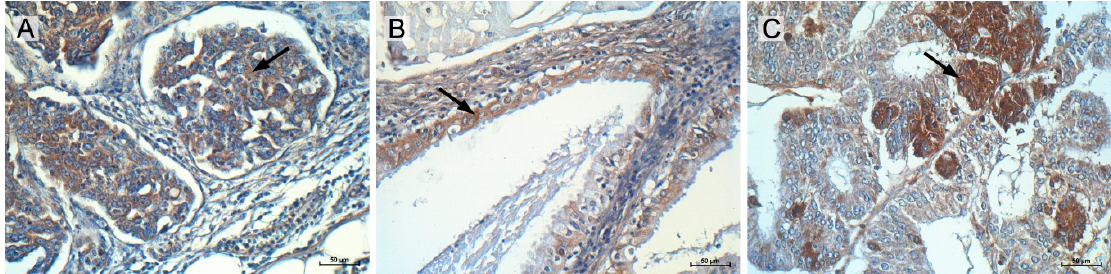
Figure 6. Immunohistochemical expression of MGP in serous adenocarcinoma patient (weak) ( A ); mucinous ovarian cancer patient (weak) ( B ); and endometrioid adenocarcinoma patient (moderate/strong) ( C ). Arrows point the cytoplasmic MGP expression in cancer cells. Sections were counterstained with hematoxylin. Scale bar = 50 μ m.